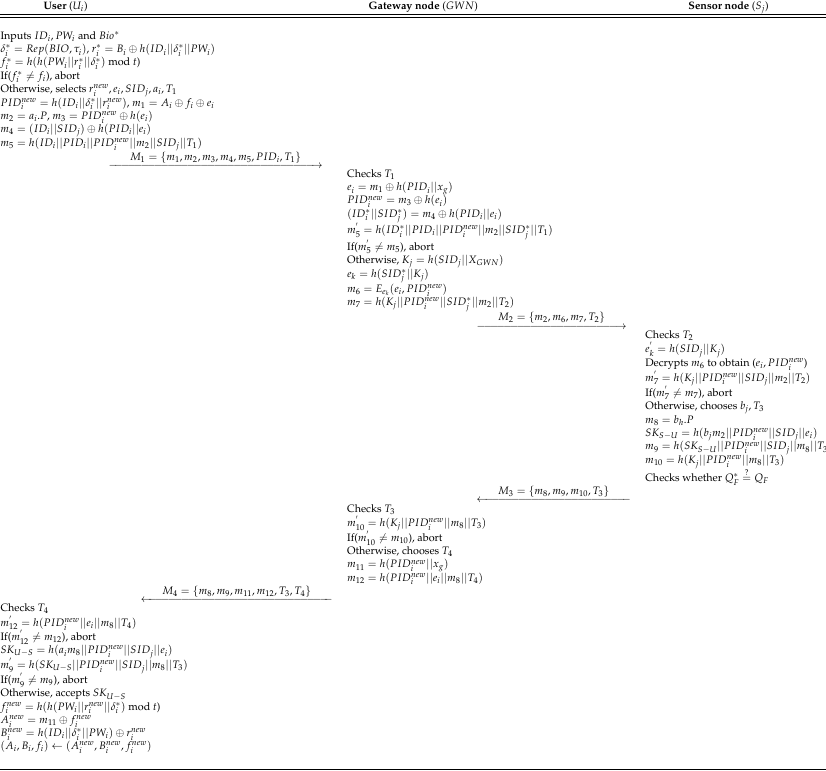
Figure 3. Authentication process of Mo and Chen’s